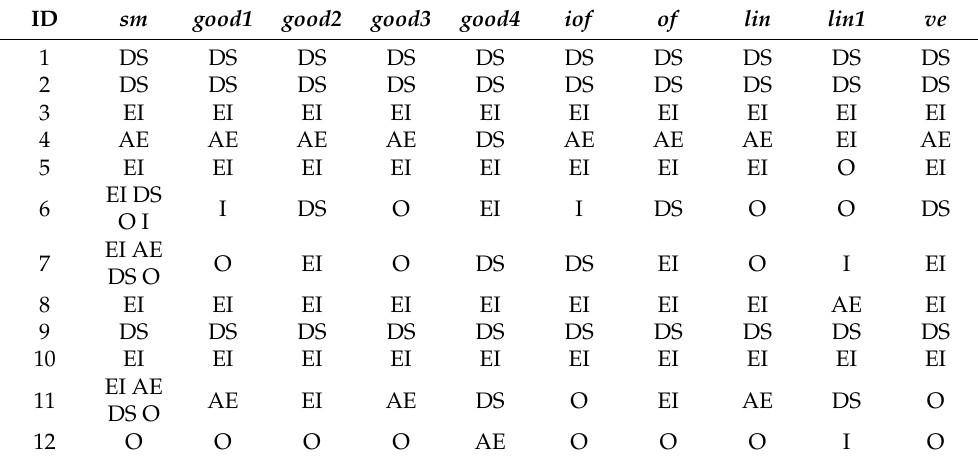
Table 5. Classification results using 10 different distance measures for 12 selected